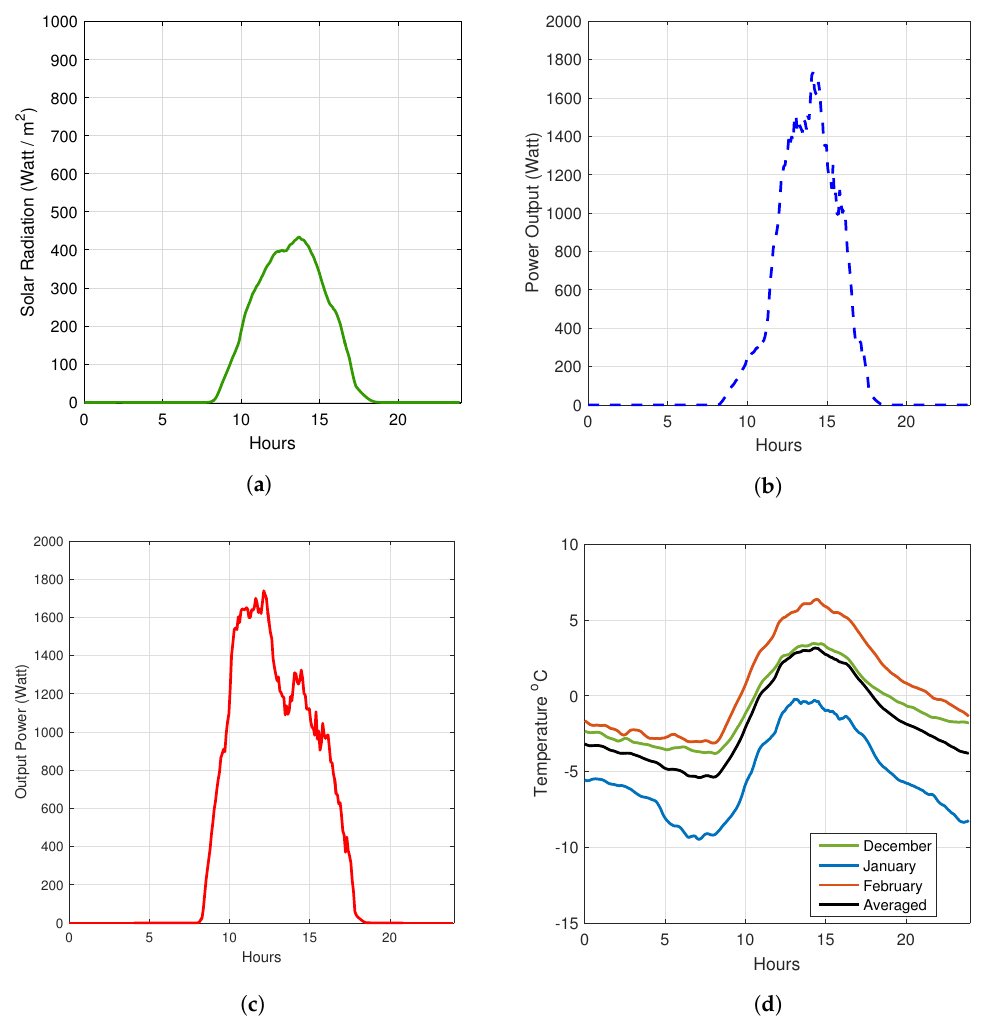
Figure 5. ( a ) Averaged global solar radiation values in winter; ( b ) Averaged fixed photovoltaic (PV) panel power output values in winter; ( c ) Averaged output power values of sun tracking PV panels in winter; ( d ) Averaged ambient temperature